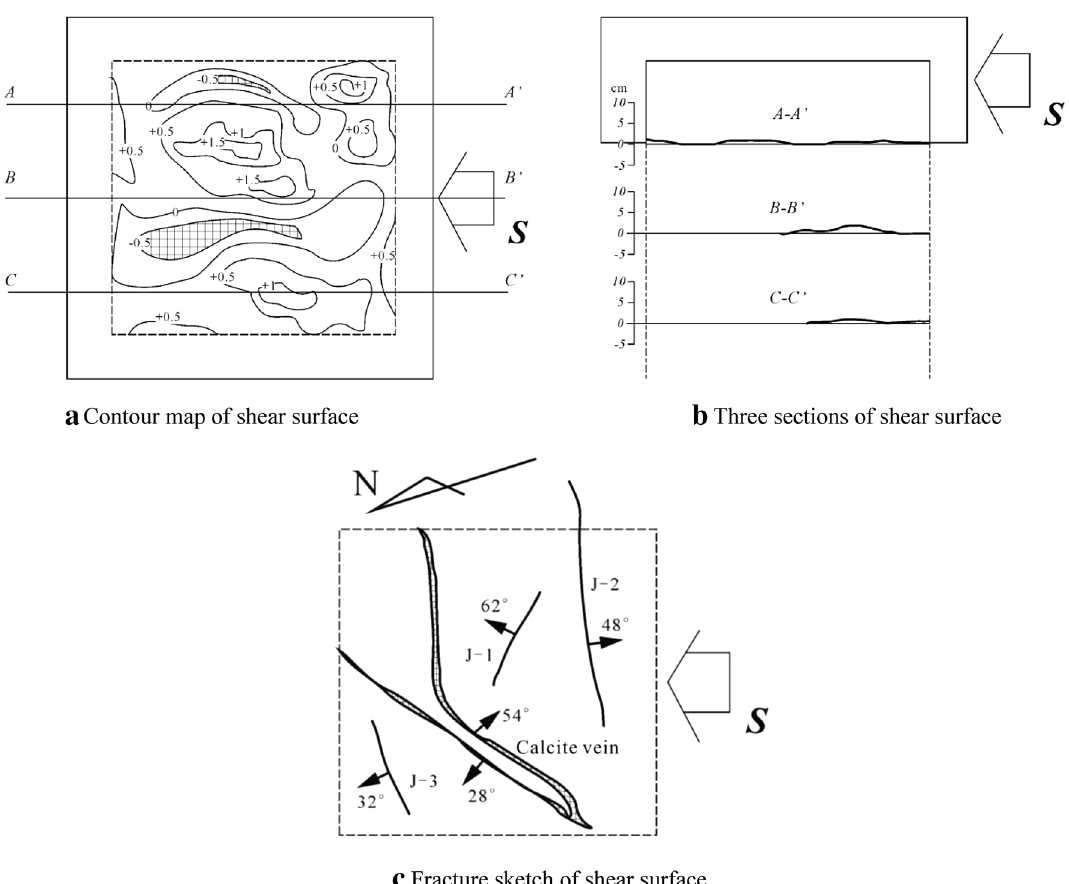
Figure 10. Characteristics of shear